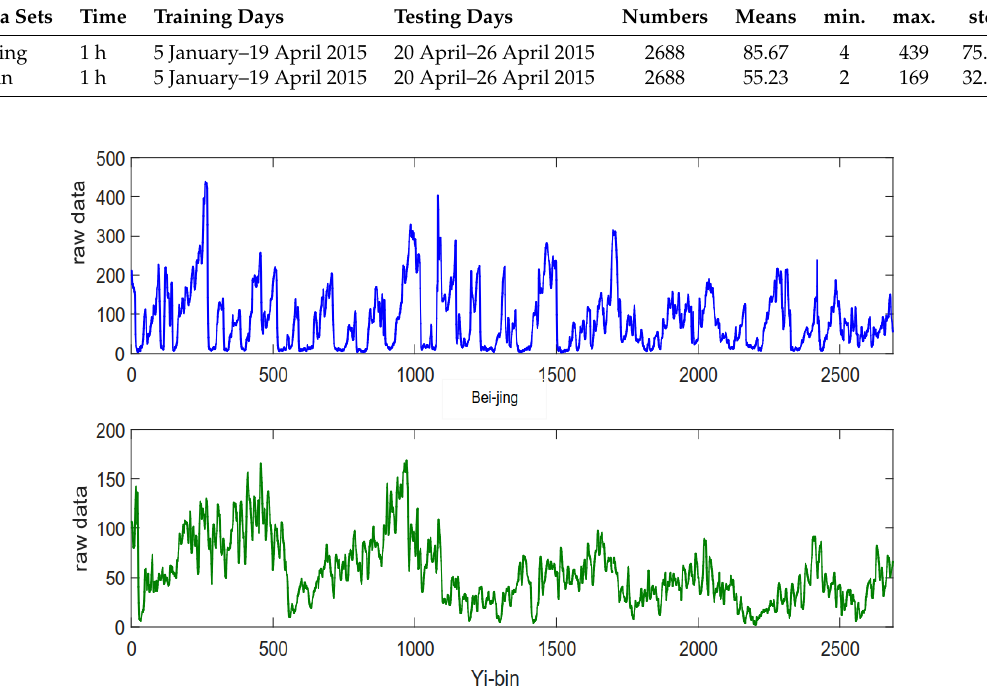
Figure 2. Raw data in Beijing and Yibin,